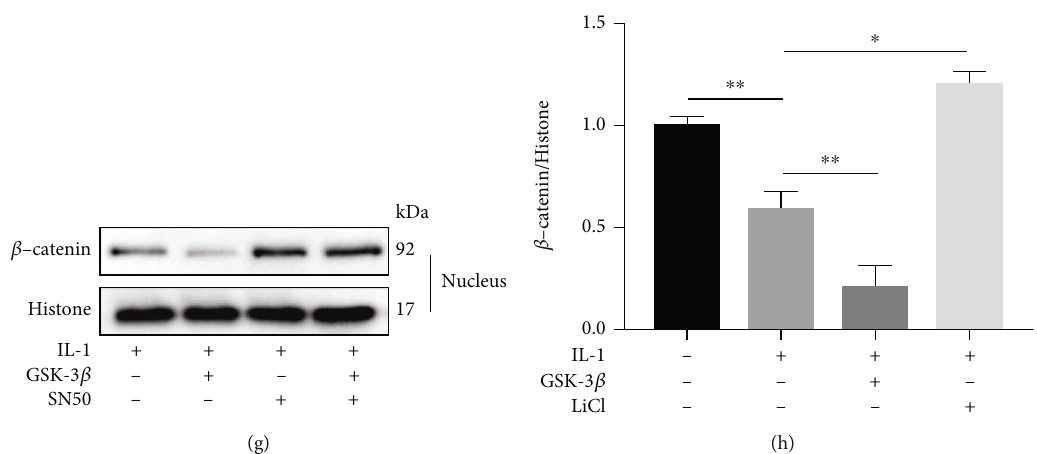
Figure 5: GSK-3 β regulates the Wnt/ β -catenin signaling pathway in IL-1 β -induced in fl ammation. Phosphorylation and total expression of GSK-3 β (a) and (b) and β -catenin (c) and (d) were detected by western blotting. (e)-(h) visualization and quanti fi cation of the expression of nuclear β -catenin. All results are expressed as the mean ± SD ( n = 3 ). NS: not signi fi cant, ∗ P < 0 : 05 , and ∗∗ P < 0 : 01